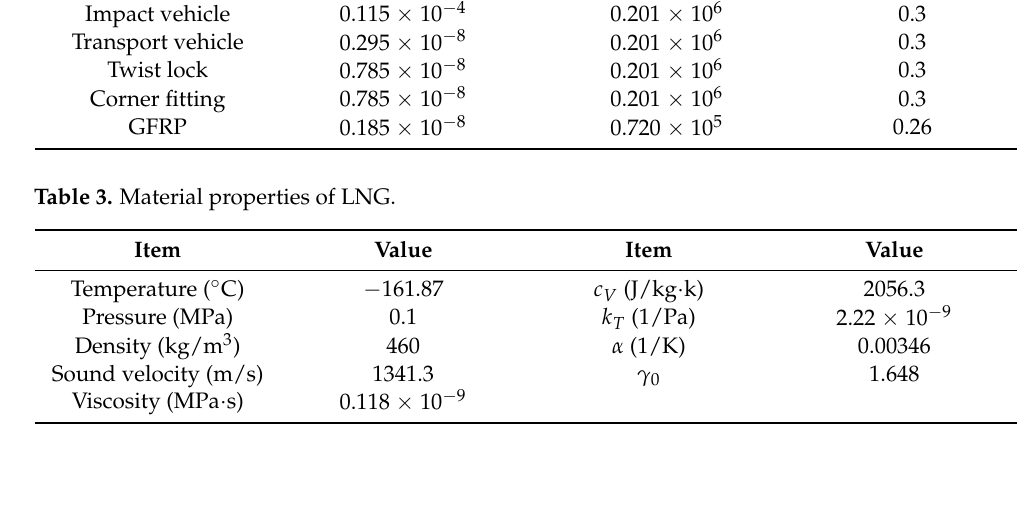
Table 3. Material properties of LNG.